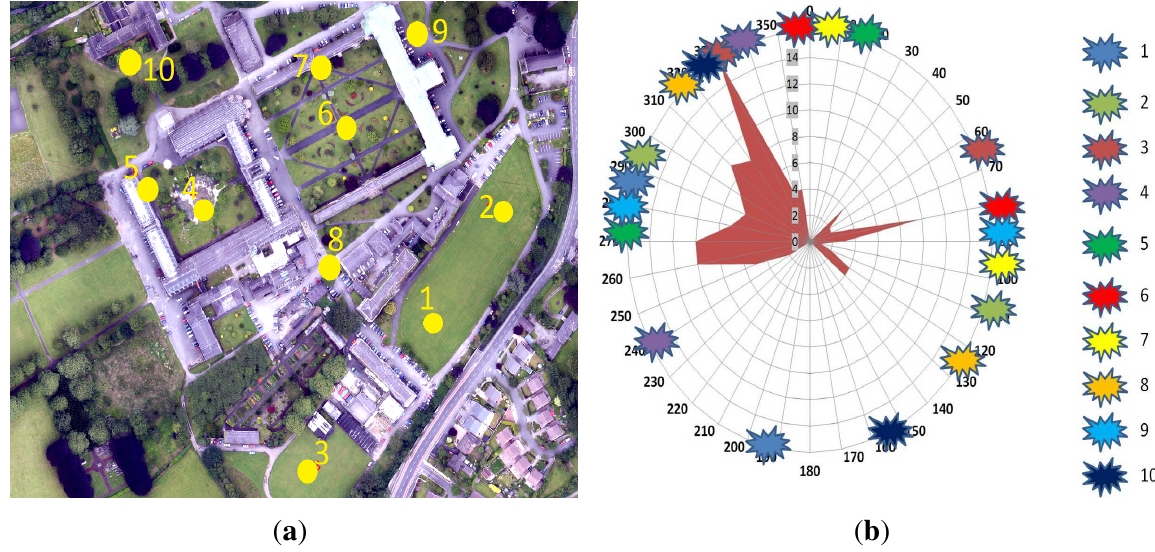
Figure 10. Validation tests ( a ) validation points selected as representative of the surrounding environment ( b ) azimuth of the two predominant shadowing objects throughout the validation tests at each of the ten test